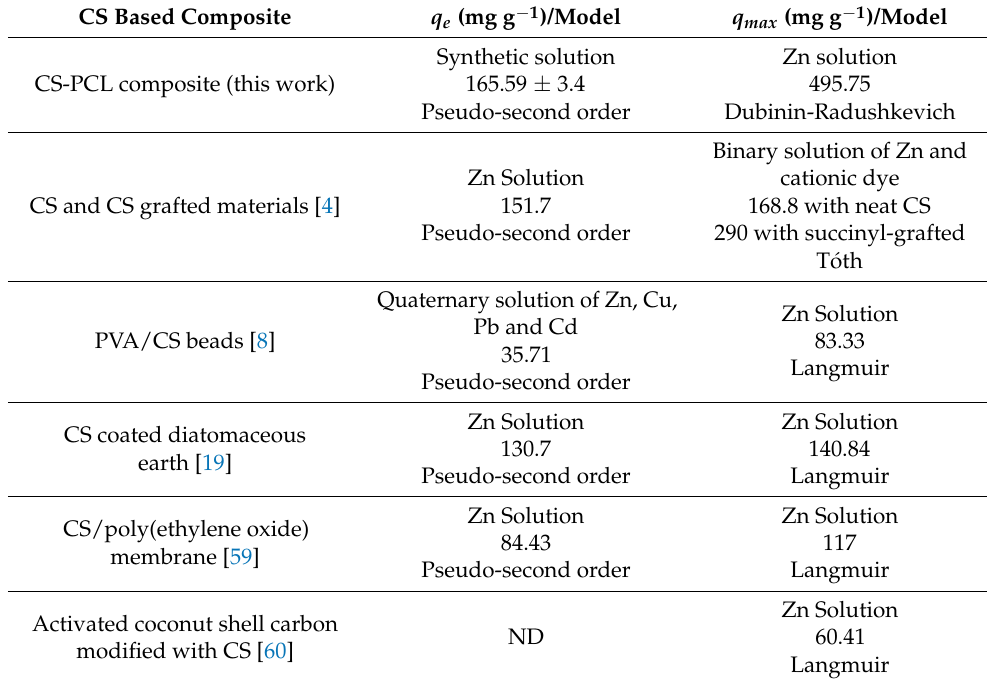
Figure 7. Adsorption experimental data fitted to PSO ( a ) and kinetic parameters for the adsorption of heavy metals in synthetic water into MCP ( b ). Table 1. Comparison of the Zn adsorption capacity into MCP with other CS based